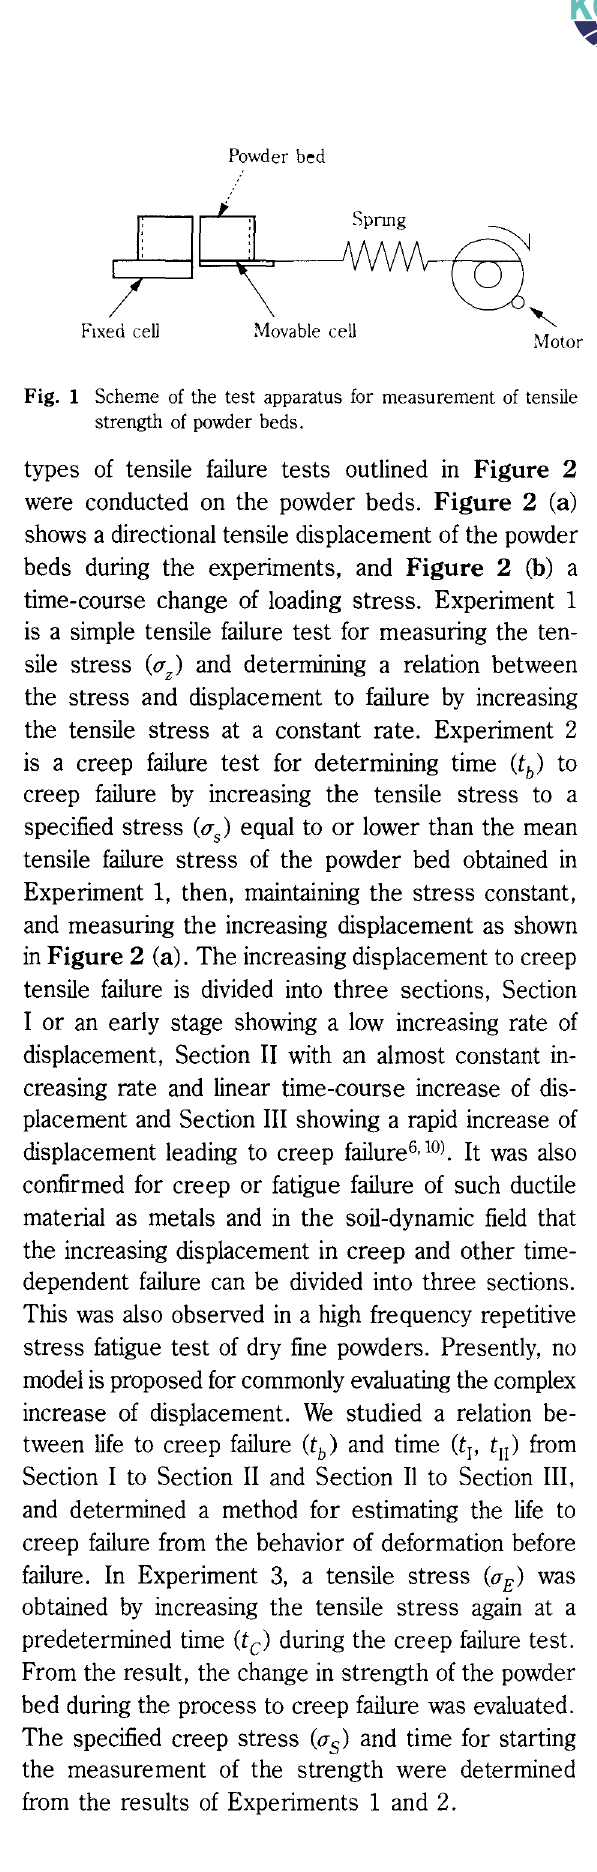
Fig. 1 Scheme of the test apparatus for measurement of tensile strength of powder